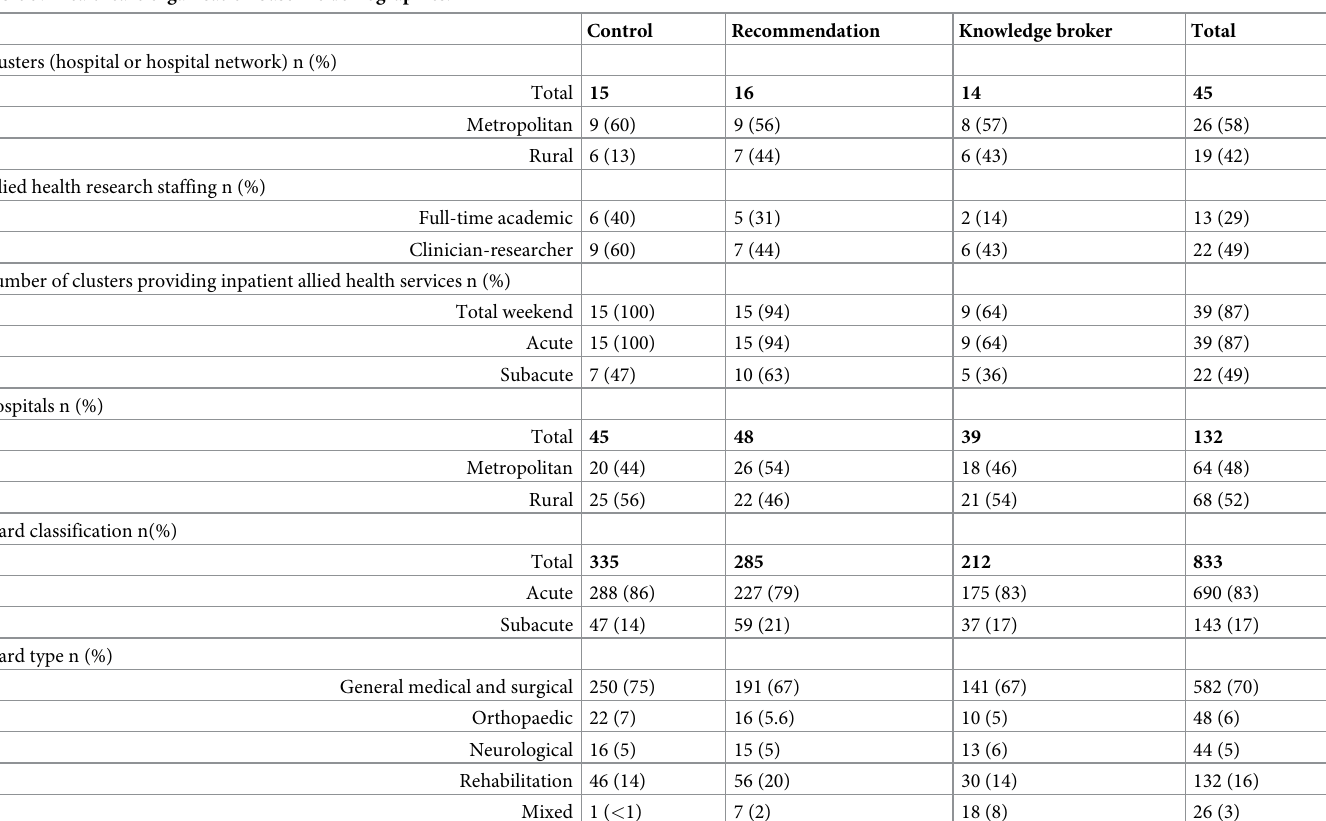
Table 3. Healthcare organisation baseline demographics.